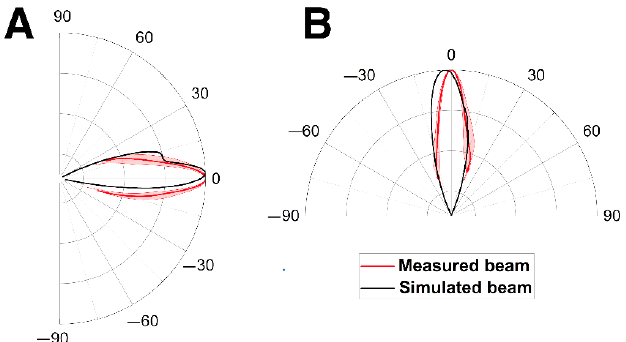
Figure 6. Comparison of simulated and measured far-field beam patterns in ( A ) the vertical and ( B ) the horizontal planes. The red shadow represents the standard deviation of measured data.